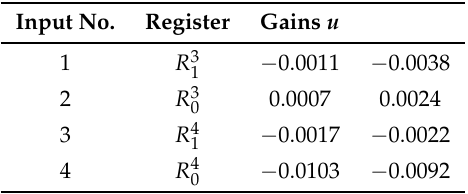
Table 1. CFLED K matrix values for registers in Figure